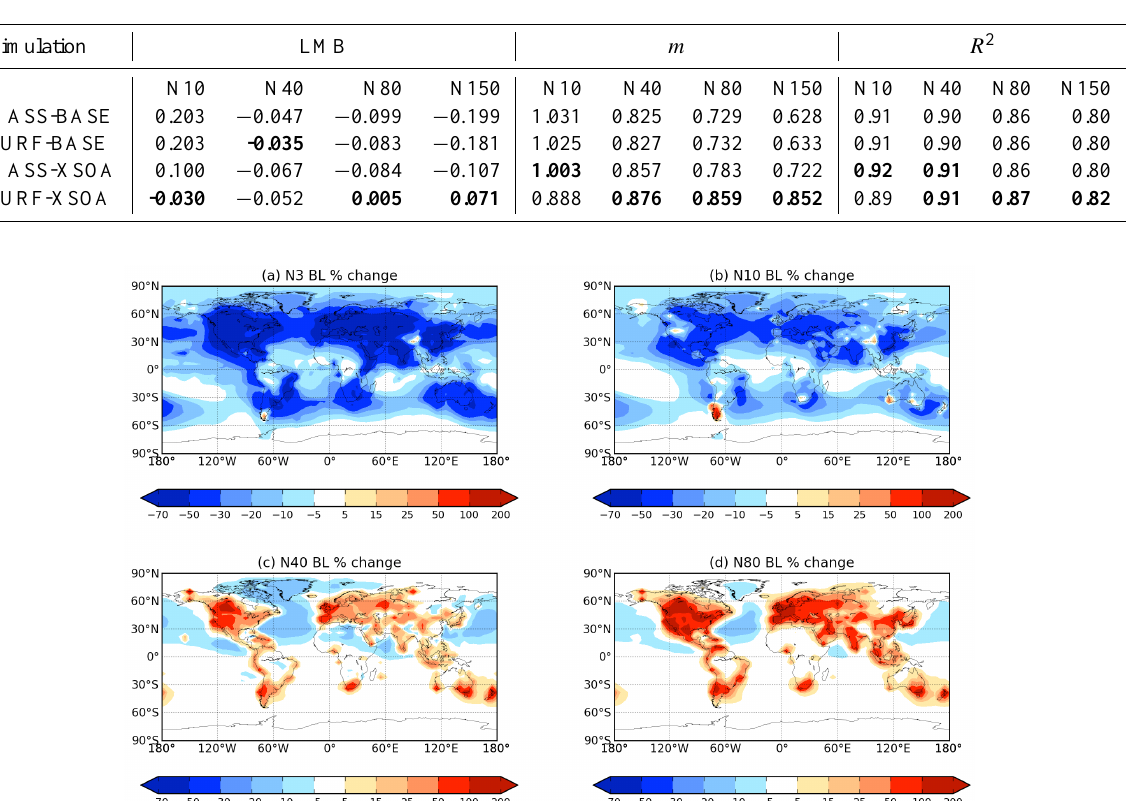
Table 3. Summary of the log-mean bias (LMB), slope of the linear regression ( m) and correlation ( R 2 ) for the different simulations. These statistics are found by comparing the annual-average values of the aerosol number concentrations across all sites. Bolded numbers represent the best statistical result between all simulations.